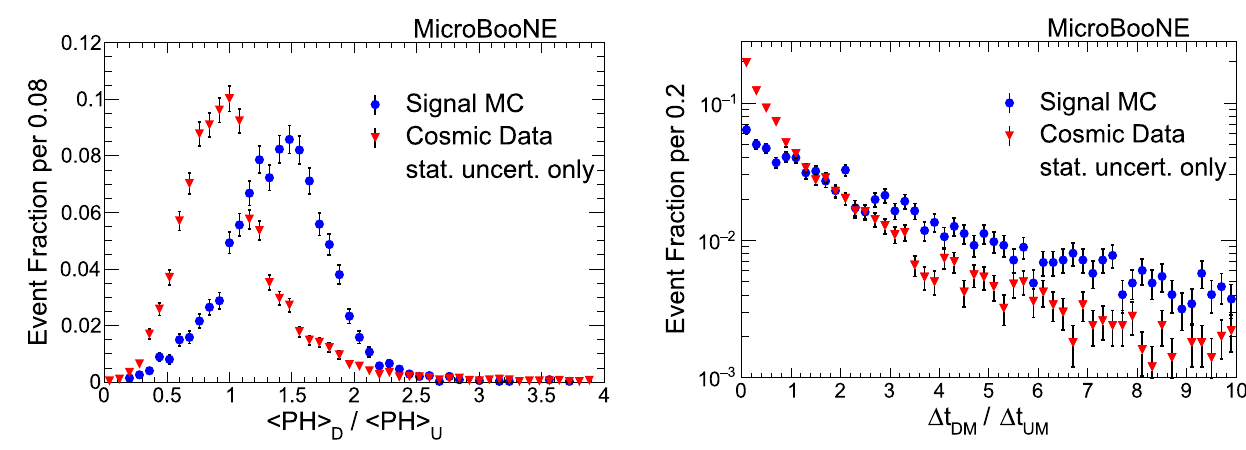
Fig. 7 Multiple Coulomb scattering (MCS) downstream to upstream > 1 pass the MCS ratio. Events with (cid:11) t DM (cid:11) t UM